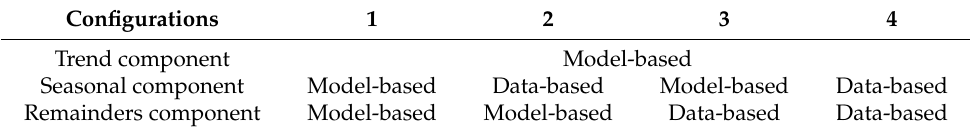
Table 1. Simulation settings (The details of the two approaches were given in Section